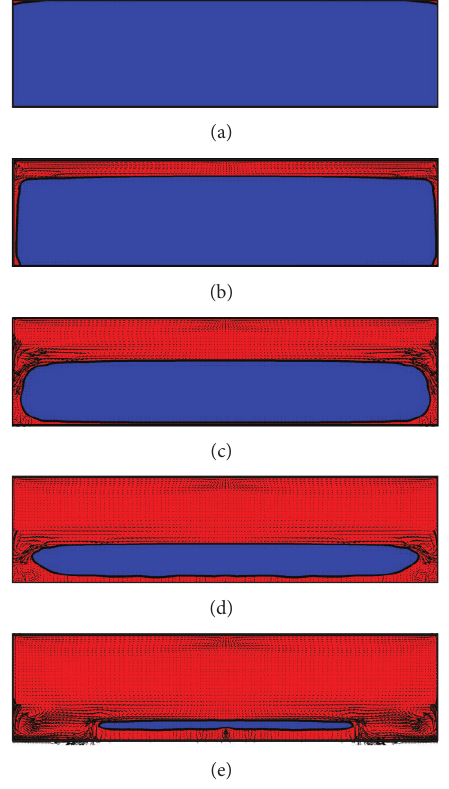
Figure 4: Melting process in conventional DS furnace for power distribution ratio of 10: 0: (a) 480 min; (b) 540min; (c) 600min; (d) 660 min; (e) 720